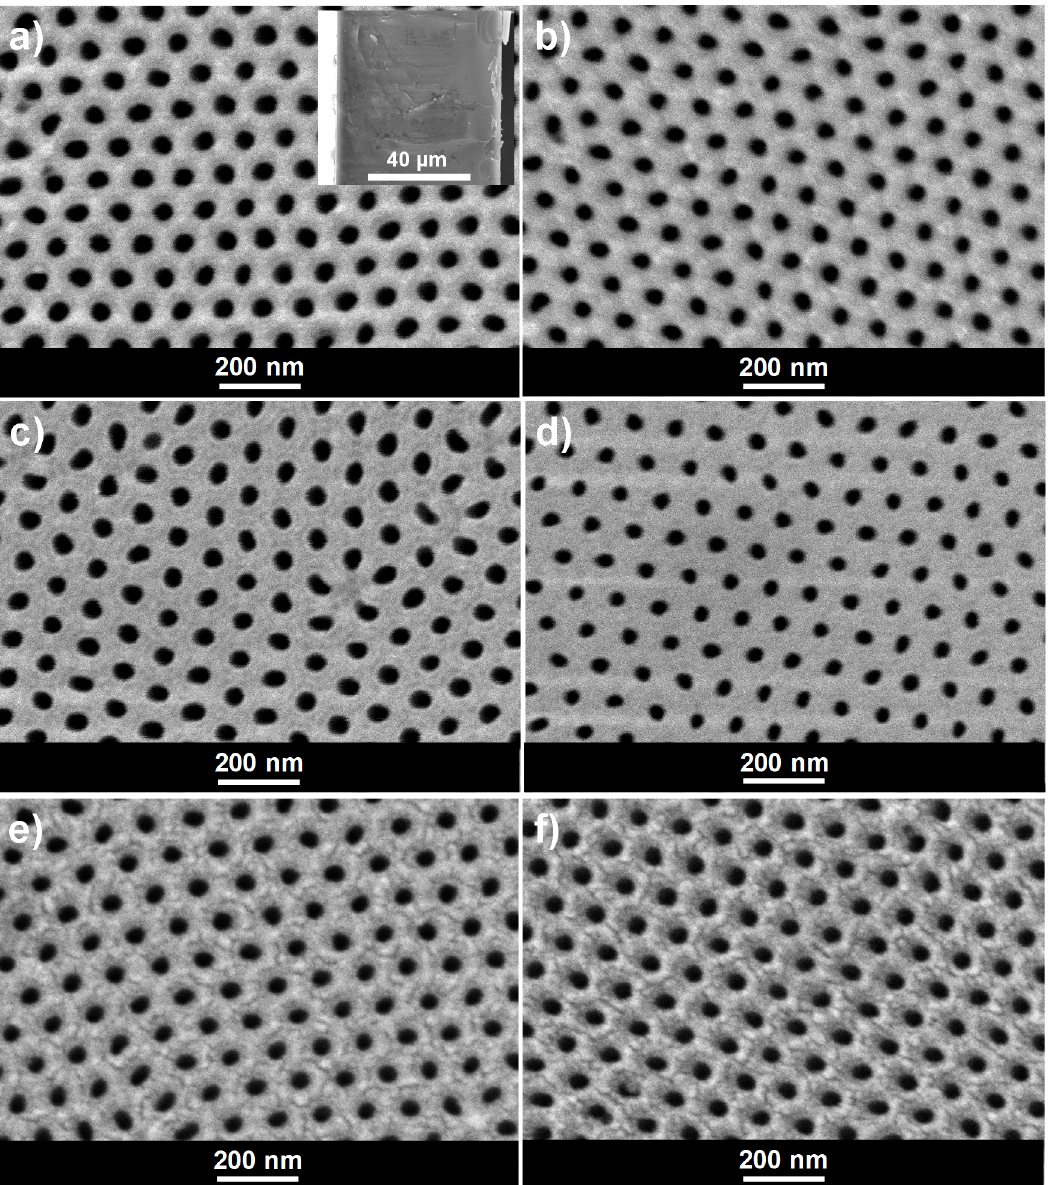
Figure 2. SEM micrographs of nanoporous alumina membrane ( a ) as produced (Ox sample), top view and cross section (inset); ( b ) after ALD SiO 2 deposition (Ox+SiO 2 ), top view; ( c ) as produced (Ox sample), bottom view ( d ) after ALD SiO 2 deposition (Ox+SiO 2 ), bottom view ( e ) after SiO 2 /APTES ALD cycle (Ox+SiO 2 /APTES), and ( f ) after SiO 2 /APTES/O 3 ALD cycle (Ox+SiO 2 /APTES/O 3 ).